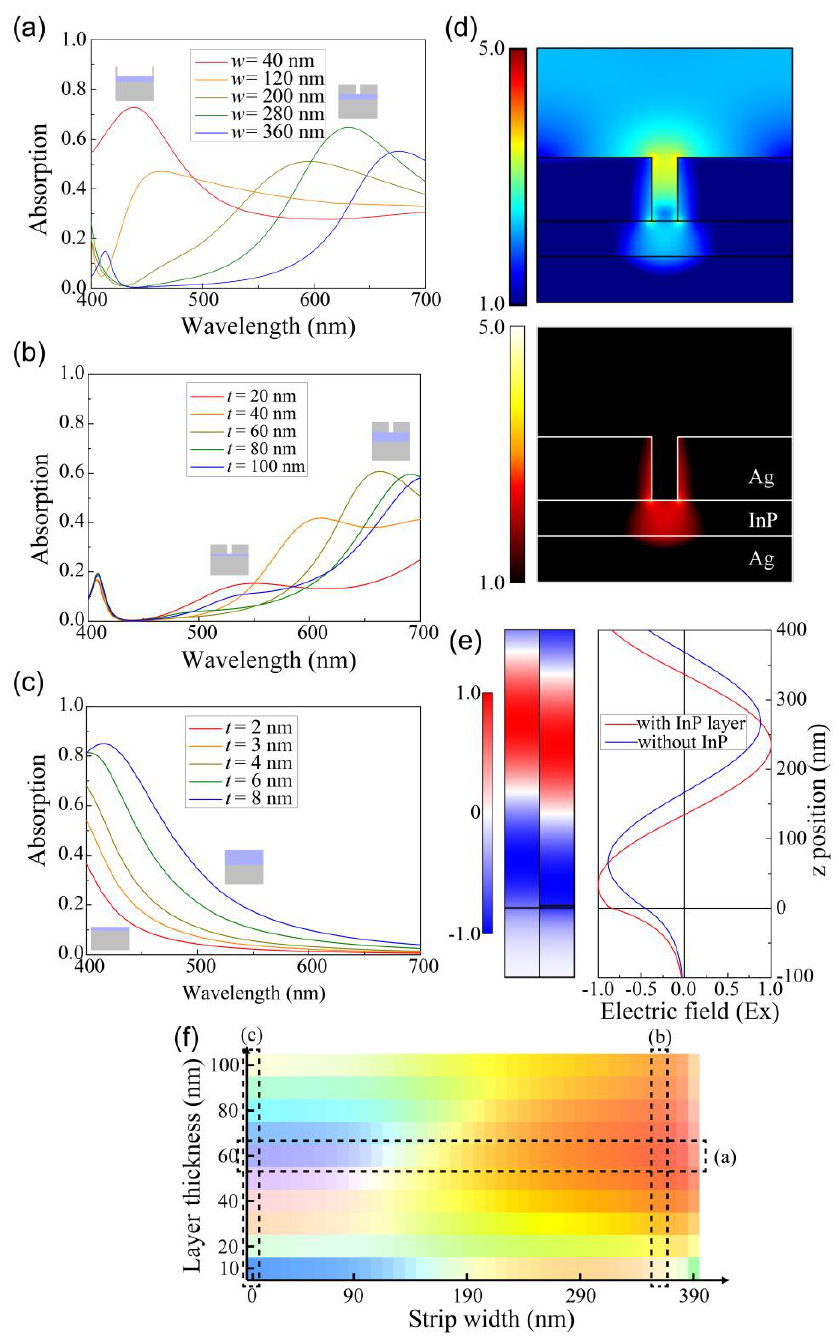
Figure 2. Absorption spectrums detected by the metamaterial detectors ( a ) when the width ( w ) of the strip varies with the thickness ( t ) of the indium phosphide (InP) layer fixed at 60 nm; ( b ) when t varies with w fixed at 350 nm; and ( c ) when t varies without the Ag strips. The insets depict the narrowest / widest width ( w ) and thinnest / thickest thickness ( t ) structures. ( d ) Electric field intensity (up) and absorption mode profiles (down) when w = 359 and t = 56 nm, in which the color red is mostly detected. ( e ) Field profiles of the x component of the electric field ( E x ) when light is incident on an Ag substrate with or without a 3-nm InP layer for the incident light with a wavelength of 400 nm. The left side profile and red line represent the E x field when the light is incident on the Ag substrate. The right side profile and blue line represent the E x field with a 3-nm InP layer on the same substrate. ( f ) Detected color by the color detector for various strip widths and InP layer thicknesses.